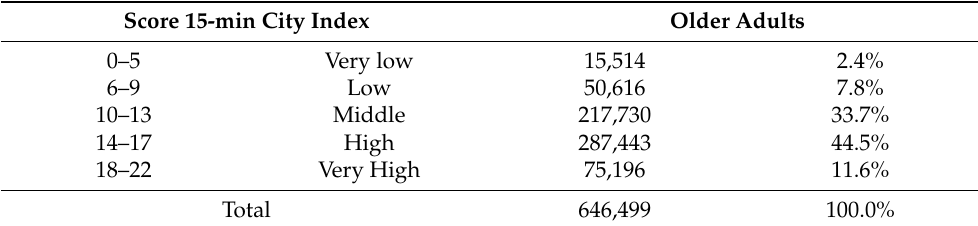
Figure 2. Spatial distribution of the 15-min accessibility index to the city. Table 2. Percentage of older adults according to level of accessibility to the 15-min